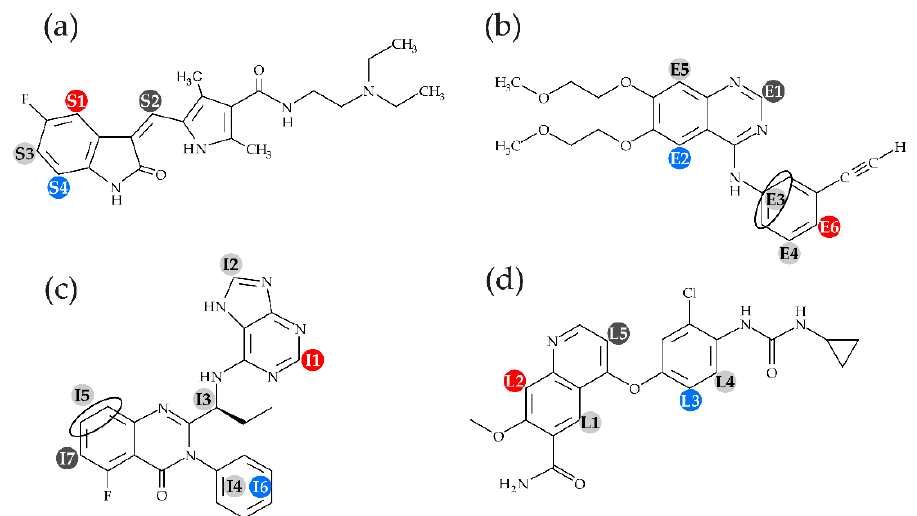
Figure 1. Structures and proton assignment of the researched kinase inhibitors ( a ) suntinib, ( b ) erlotinib, ( c ) idelalisib, ( d ) lenvatinib, as well as the protons used in 1 H- 1 H MAS NOESY NMR.